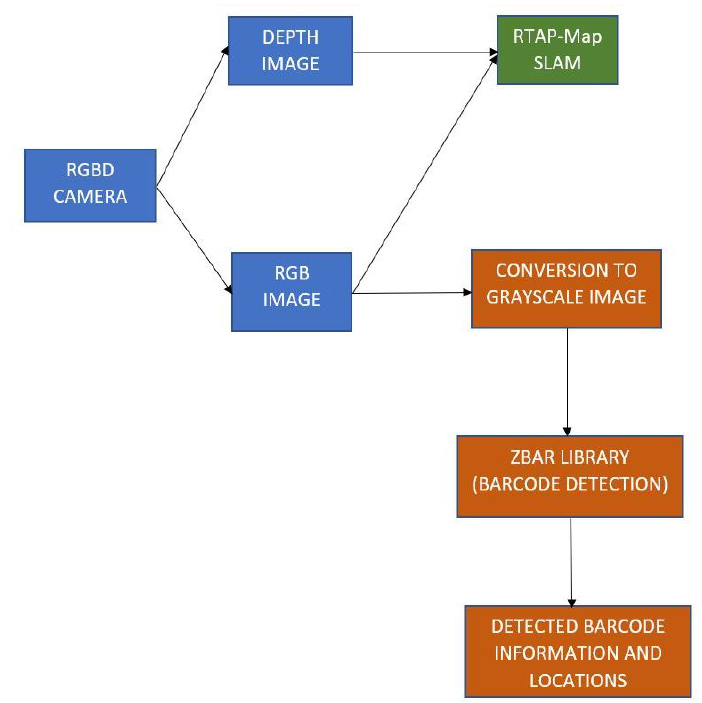
Figure 4. Barcode detection and SLAM